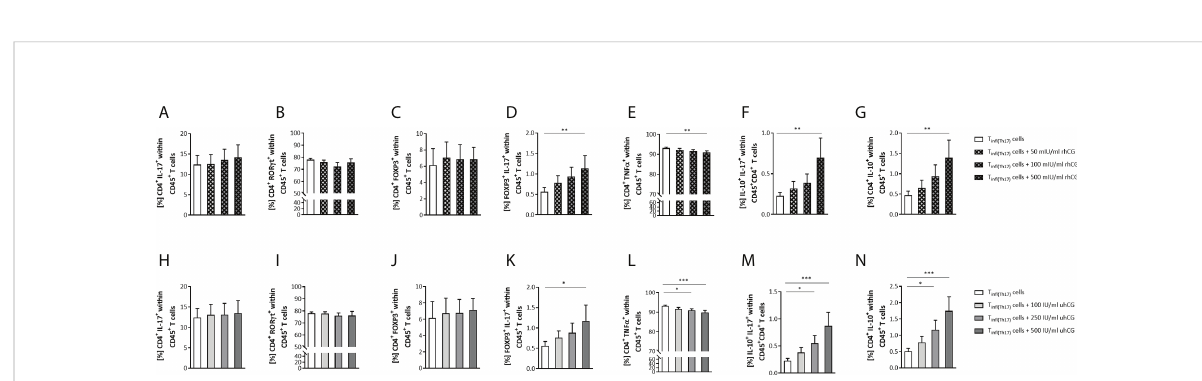
FIGURE 5 rhCG and uhCG induced differentiation of Th17 cells to anti-in fl ammatory subtypes. Naïve CD4 + T cells were isolated by magnetic-activated cell sorting (MACS) and polarized into Th17 cells under Th17-differentiating conditions for 3 days in vitro . Following they were exposed to uhCG (100 IU/ml, 250 IU/ml or 500 IU/ml) or rhCG (50 mIU/ml, 100 mIU/ml or 500 mIU/ml) for 24 h under continuing Th17-differentiating conditions. Percentages of different T cell subsets as well as intracellular cytokine production were determined by fl ow cytometry. (A – N) Graphs showing the percentages of CD4 + IL-17 + , CD4 + ROR g t + , CD4 + FOXP3 + , FOXP3 + IL-17 + , CD4 + TNF a + , IL-10 + IL-17 + and CD4 + IL-10 + cells within CD45 + T cells in the rhCG (A – G) or uhCG (H – N) treatment groups. T inf(Th17) cells from WT ( n = 5) female mice were included in the assays. All assays were run in duplicate. Data are presented as the mean plus standard error of the mean (S.E.M.). Statistical analysis among groups was performed using the Friedman test followed by Dunn ’ s multiple-comparison test. Following, means plus S.E.M. are provided for signi fi cant differences between groups for FOXP3 + IL-17 + : 0.5617 ± 0.1064 vs 1.135 ± 0.3112 (w/o hCG vs 500mIU rhCG), 0.5609 ± 0.1068 vs 1.173 ± 0.3895 (w/o hCG vs 500IU uhCG); for CD4 + TNF a + : 93.11 ± 0.4625 vs 91.00 ± 0.7252 (w/o hCG vs 500mIU rhCG), 93.11 ± 0.4625 vs 90.94 ± 0.7986 (w/o hCG vs 250IU uhCG), 93.11 ± 0.4625 vs 89.87 ± 1.019 (w/o hCG vs 500IU uhCG); for IL-10 + IL-17 + : 0.2278 ± 0.04261 vs 0.6995 ± 0.2387 (w/o hCG vs 500mIU rhCG), 0.2278 ± 0.04261 vs 0.5502 ± 0.1425 (w/o hCG vs 250IU uhCG), 0.2278 ± 0.04261 vs 0.8713 ± 0.2508 (w/o hCG vs 500IU uhCG); for CD4 + IL-10 + : 0.4719 ± 0.1017 vs 1.394 ± 0.4336 (w/o hCG vs 500mIU rhCG), 0.5119 ± 0.08716 vs 1.168 ± 0.2930 (w/o hCG vs 250IU uhCG), 0.5119 ± 0.087116 vs 1.748 ± 0.4320 (w/o hCG vs 500IU uhCG). * indicates p < 0.05; ** indicates p < 0.01; *** indicates p < 0.001. rhCG, recombinant hCG; uhCG, urine-derived